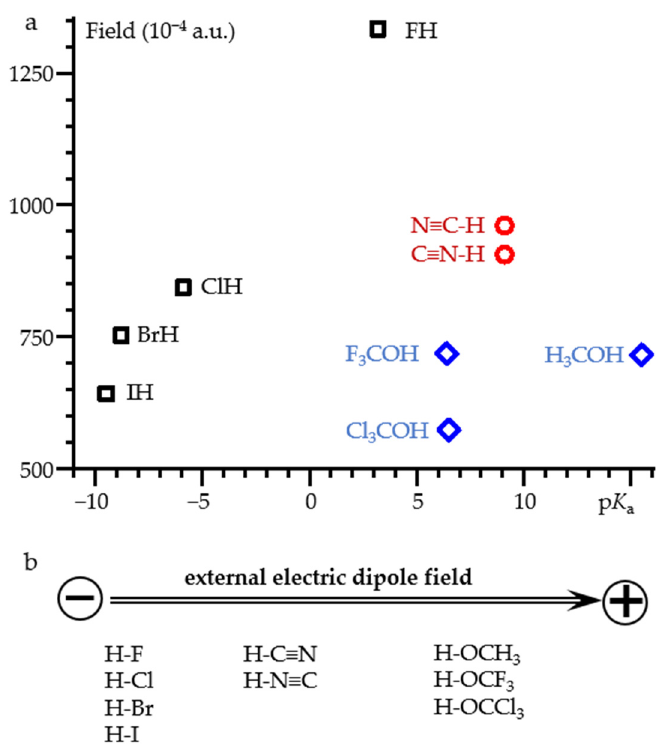
Figure 7. ( a ) The value of the external electric field required for proton dissociation of selected acids as a function of their p K a . ( b ) The orientation of the acids relative to the direction of the field. For HOCX 3 , the field is directed along the C-O bond.